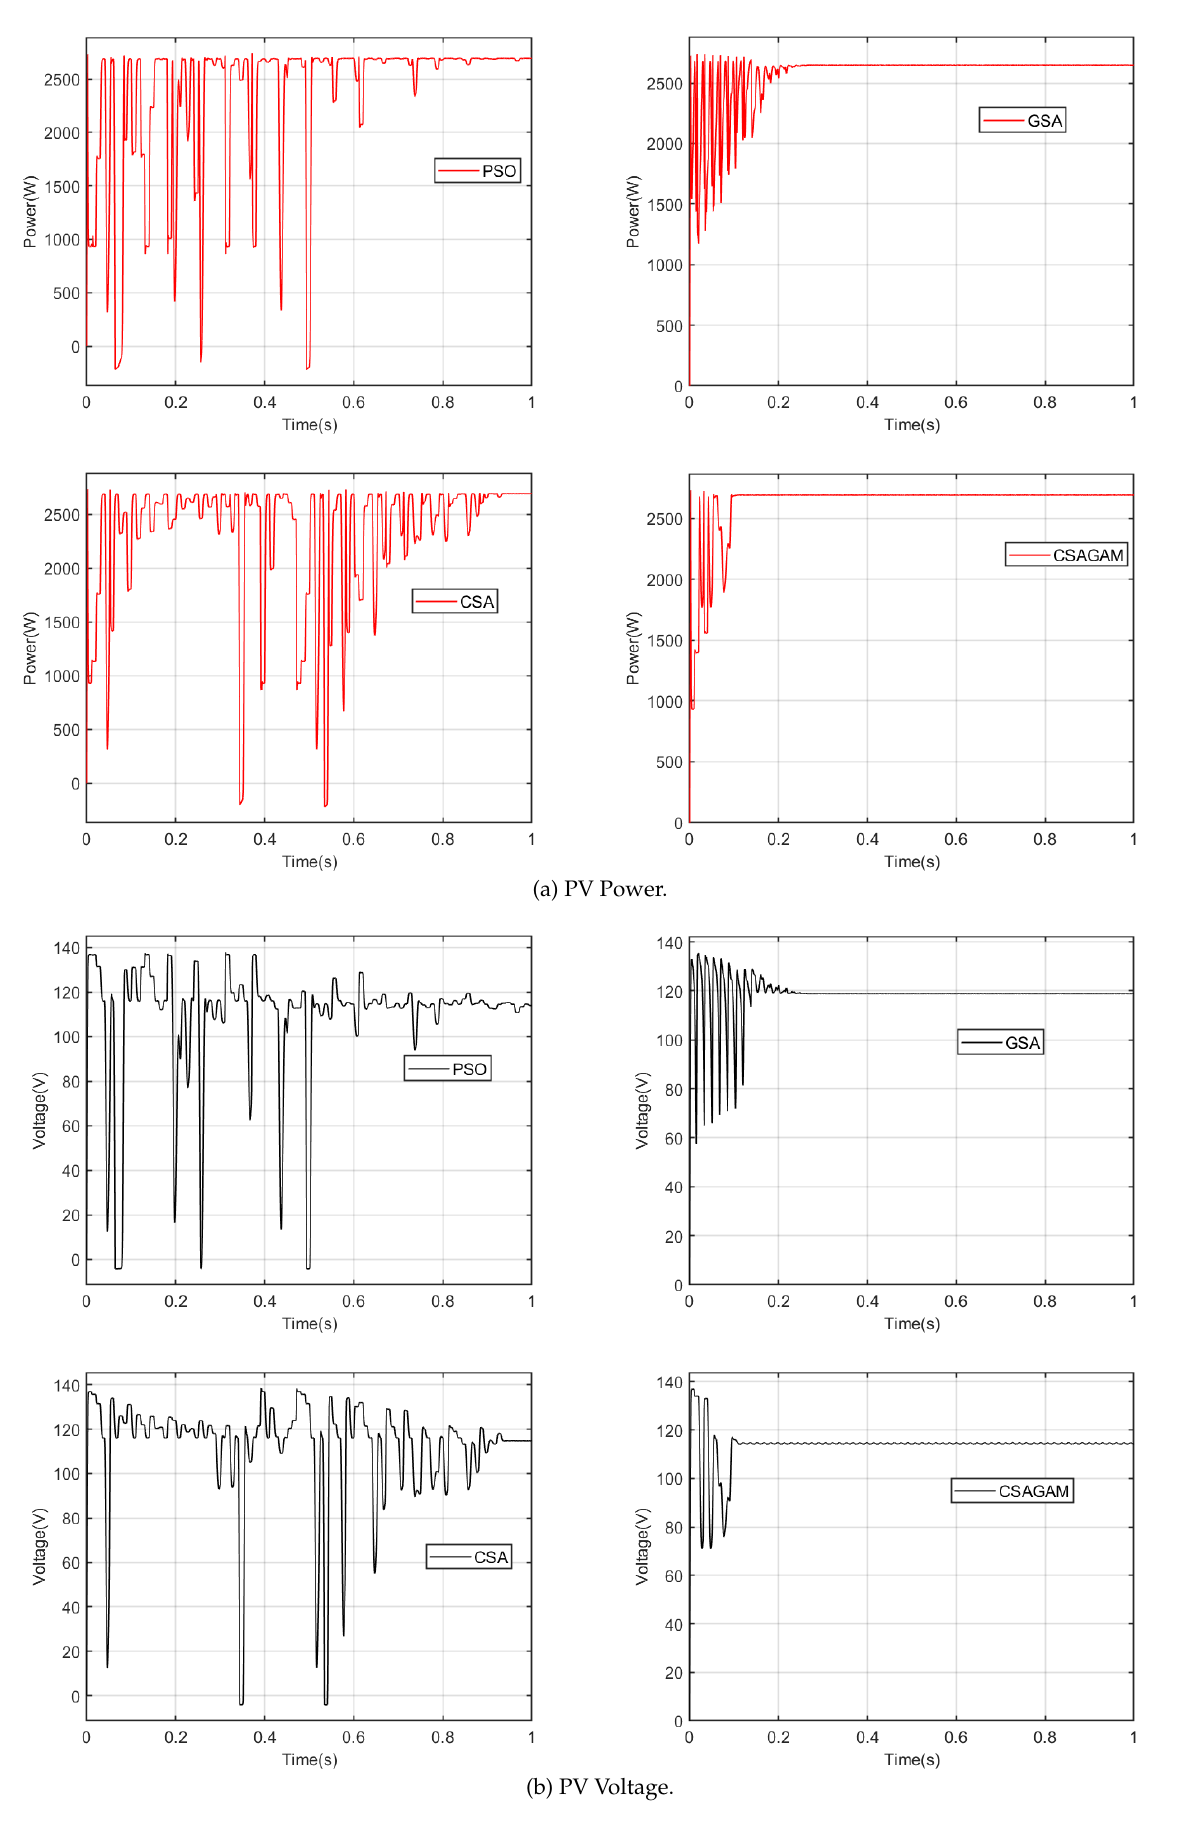
Fig. 8. Simulation results for the first partial shading case PSC